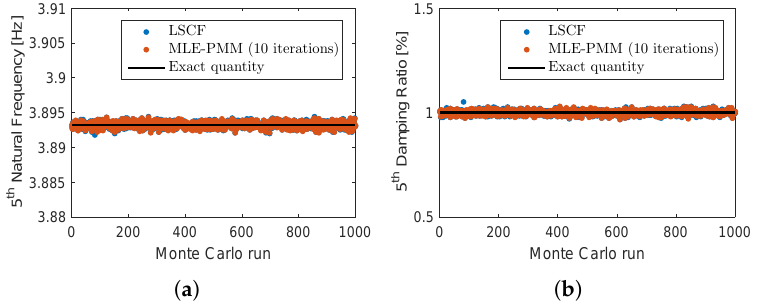
Figure 17. Monte Carlo simulation results for the 5th identified natural frequency ( a ) and damping ratio ( b ): exact quantity (solid black line), LSCF estimates (blue dots) and MLE-PMM estimates after 20 iterations (red dots). Table 8. Monte Carlo simulation results obtained from the simulated EMA of the lattice tower structure: mean natural frequencies and damping rations and their respective relative bias error computed from the LSCF estimates and from the estimates obtained with the MLE-PMM technique after 20 iterations.